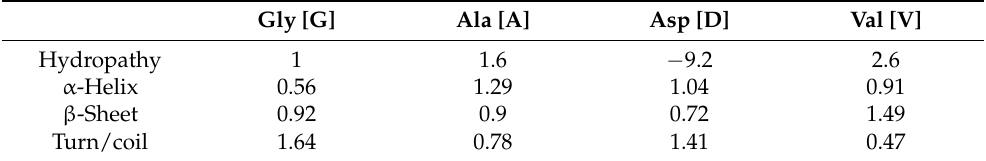
Table 2. Propensities for hydropathy, secondary structure formations of [GADV]-amino acids. Four [GADV]-amino acids with a simple chemical structure could be easily synthesized with prebiotic means (Table 1). Nevertheless, a hydrophilic Asp and a hydrophobic Val are contained in the four amino acids. In addition, α -helix forming Ala, β -sheet forming Val, and turn/coil forming Gly are also contained in the four amino acids. Numerals indicate the respective propensities quoted from Stryer’s textbook “ Biochemistry ” [14]. The splendid properties of [GADV]-amino acids make it possible to satisfy the four conditions for water-soluble globular protein formation. That is the reason why [GADV]-amino acid composition is one of protein 0th-order structure. Gly [G] Ala [A] Asp [D] Val